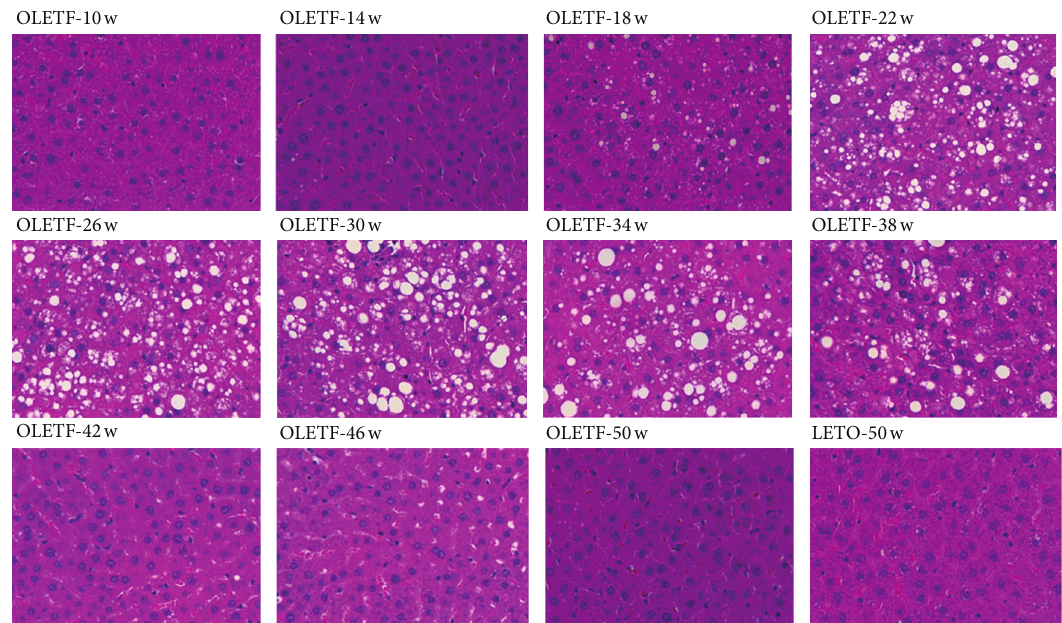
Figure 2: Liver histology by hematoxylin and eosin (H&E) staining. Histological changes in liver tissue observed by H&E staining in OLETF rats at 4-week intervals up to 50 weeks of age (magnification, × 200).